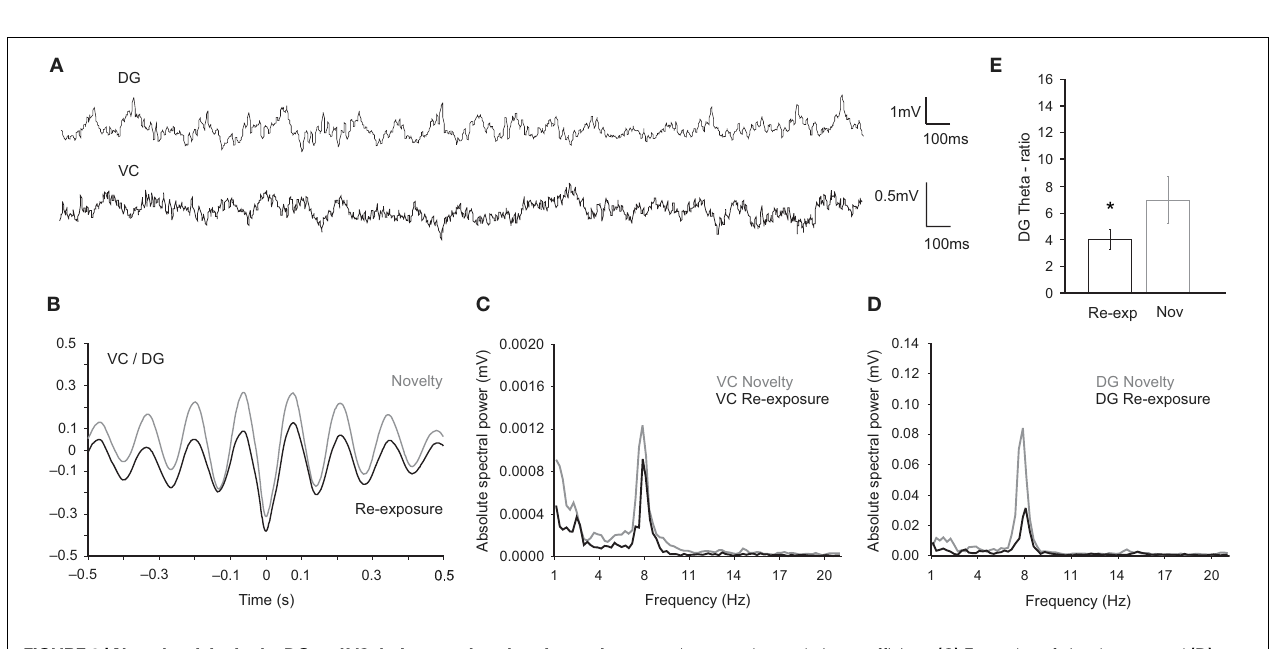
peak-to-trough correlation coeffi cient. (C) Examples of visual cortex and (D) dentate gyrus spectral powers during the re-exposure (black trace) and the novelty (grey trace) periods. Lower values are detected for the re-exposure in the range of 8 Hz frequency. (E) Theta-ratio (relative theta-delta ratio) in the re- exposure period (black bars) is lower in comparison to the novelty (grey bars) values; * p < 0.05.